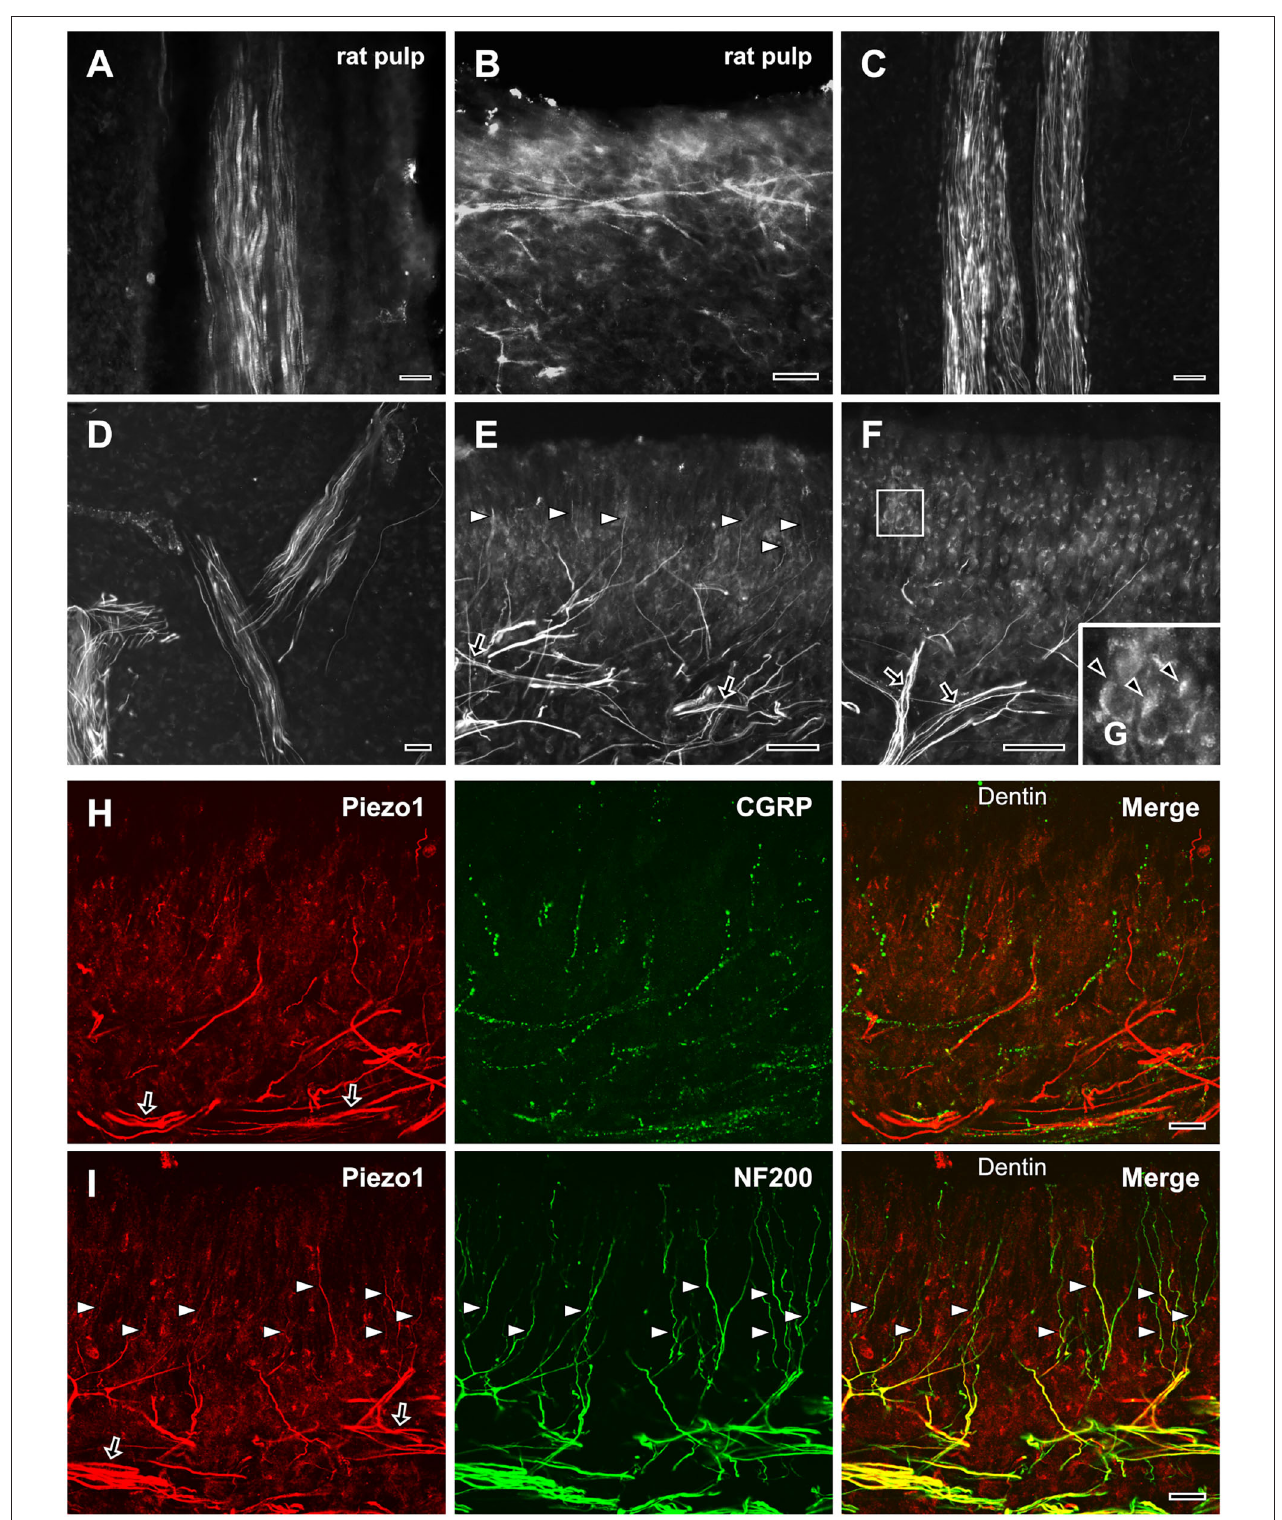
FIGURE 3 | Light micrographs of immunofluorescent staining for Piezo1 in axons in the rat (A,B) and the human dental pulp (C–G) , and double immunofluorescent staining for Piezo1 and CGRP (H) or NF200 (I) in the human dental pulp. (A,B) Piezo1 is expressed in a few axons in the rat radicular (A) and coronal (B) pulp.